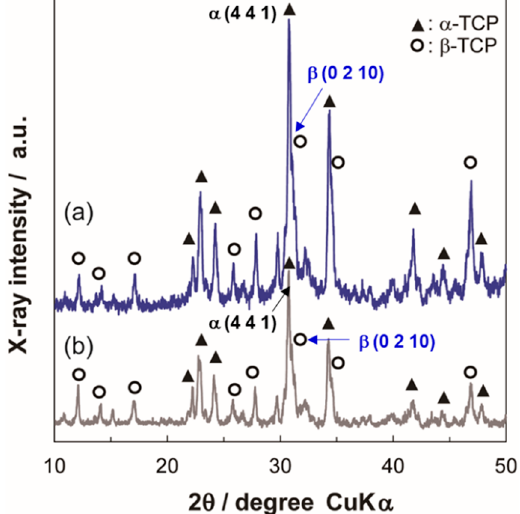
Figure 1. Characterization of as-prepared powders synthesized by ultrasonic spray-pyrolysis (USSP). X-ray diffractometry (XRD) patterns of washed sample powders of ( a ) Silver-containing tricalcium phosphate (Ag-TCP(0)) and ( b ) Ag-TCP(5).